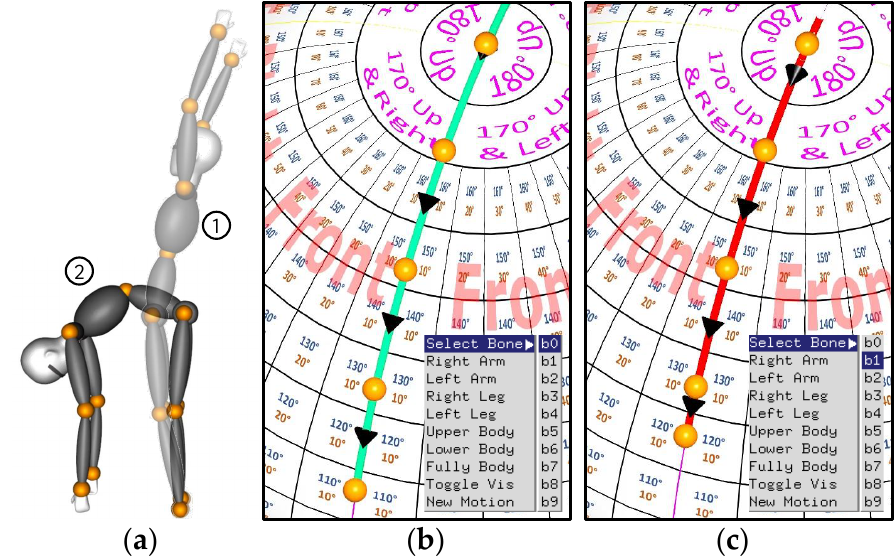
Figure 10. ( a ) Overlapping avatar depicting movement between the two key poses 1, and 2 ( b ) Visualization of trajectory on the sphere associated with pelvis ( b 0 ), selected among the menu options ( c ) Visualization of trajectory on the sphere associated with chest ( b 1 ), selected among the menu